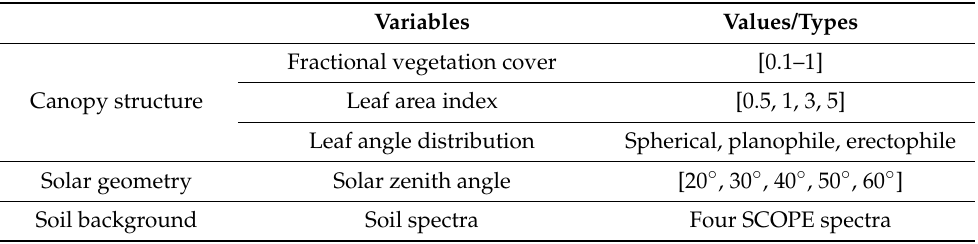
Table 2. Parameters varied in SIP and Soil-Canopy Observation of Photochemistry and Energy fluxes (SCOPE) simulations for the fraction of absorbed photosynthetically active radiation (fPAR) estimation.